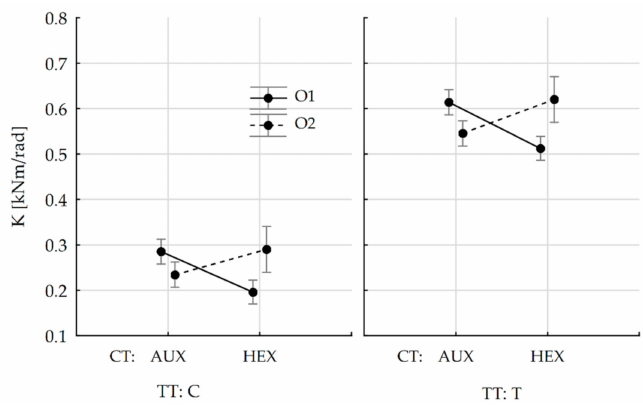
Figure 10. Change in sti ff ness coe ffi cient depending on core type (CT) and orthotropy direction (O) and also type of joint test (TT) (vertical bars mean 0.95 confidence